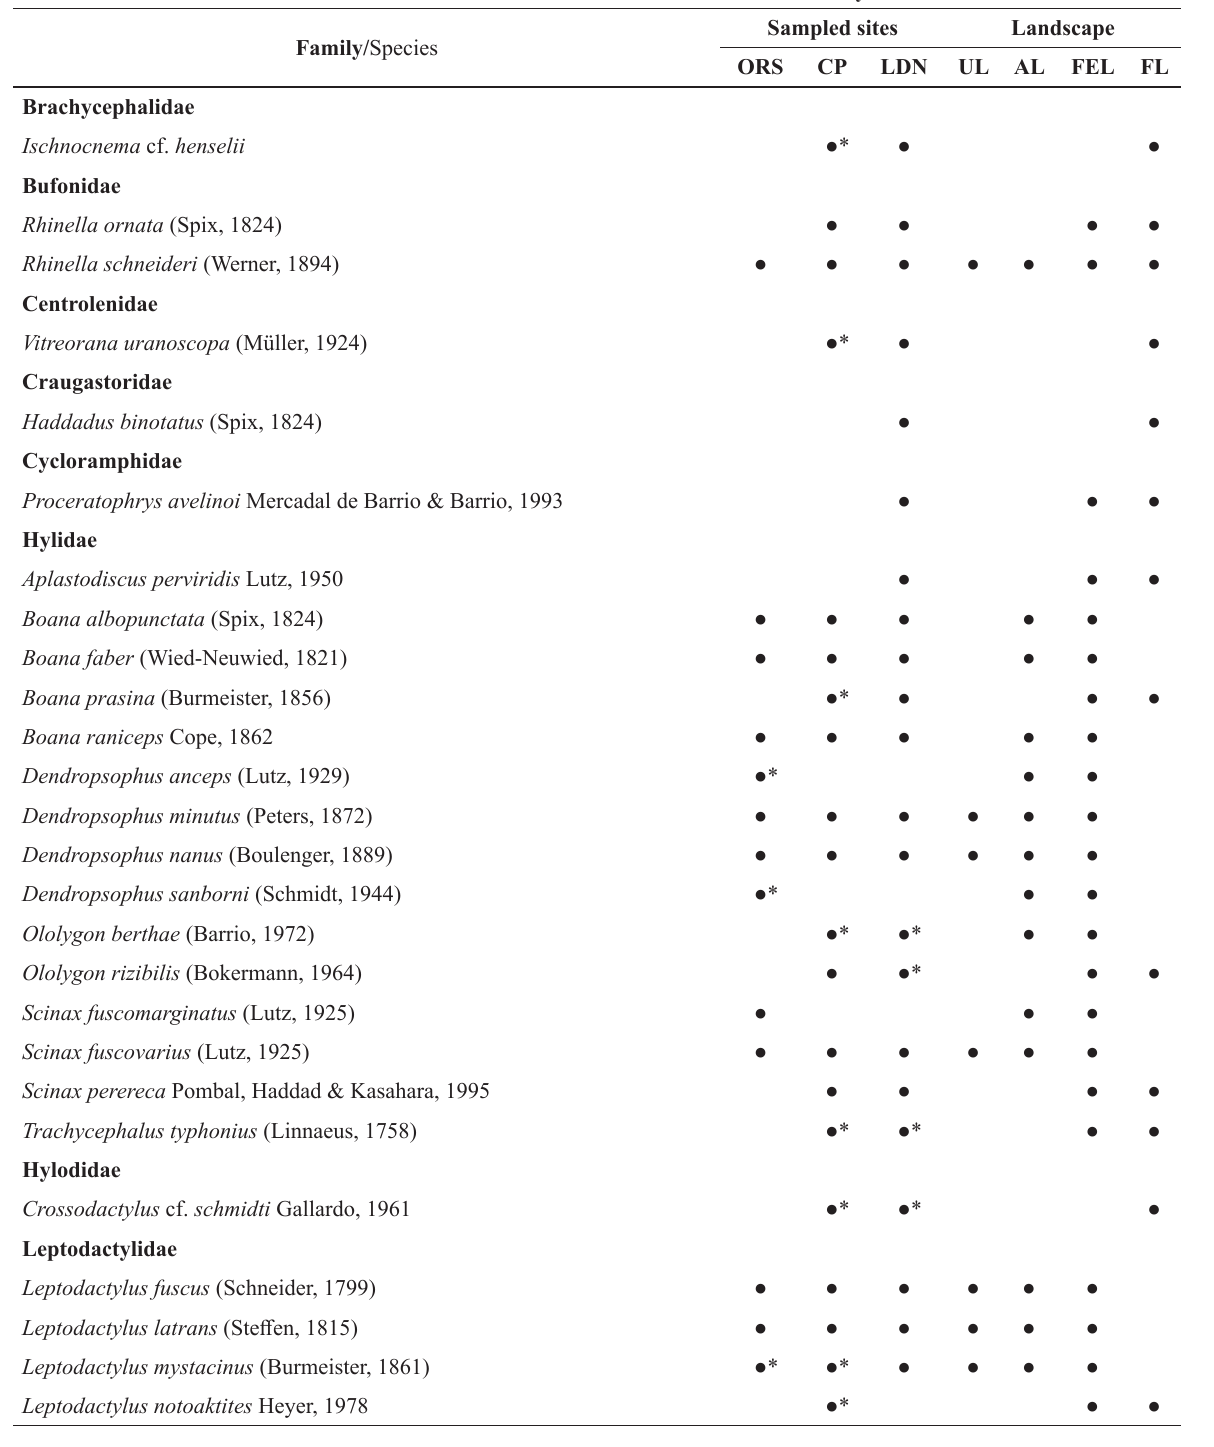
Species recorded in the Mesophytic Semideciduous Forest in the Ourinhos (ORS), Cornélio Procópio (CP) and Londrina (LDN) municipalities in 23 water bodies, southern Brazil. *Species which were found in the study region but were not recorded in water bodies between October 2010 and February 2011. Sampled sites Landscape Family/ Species ORS